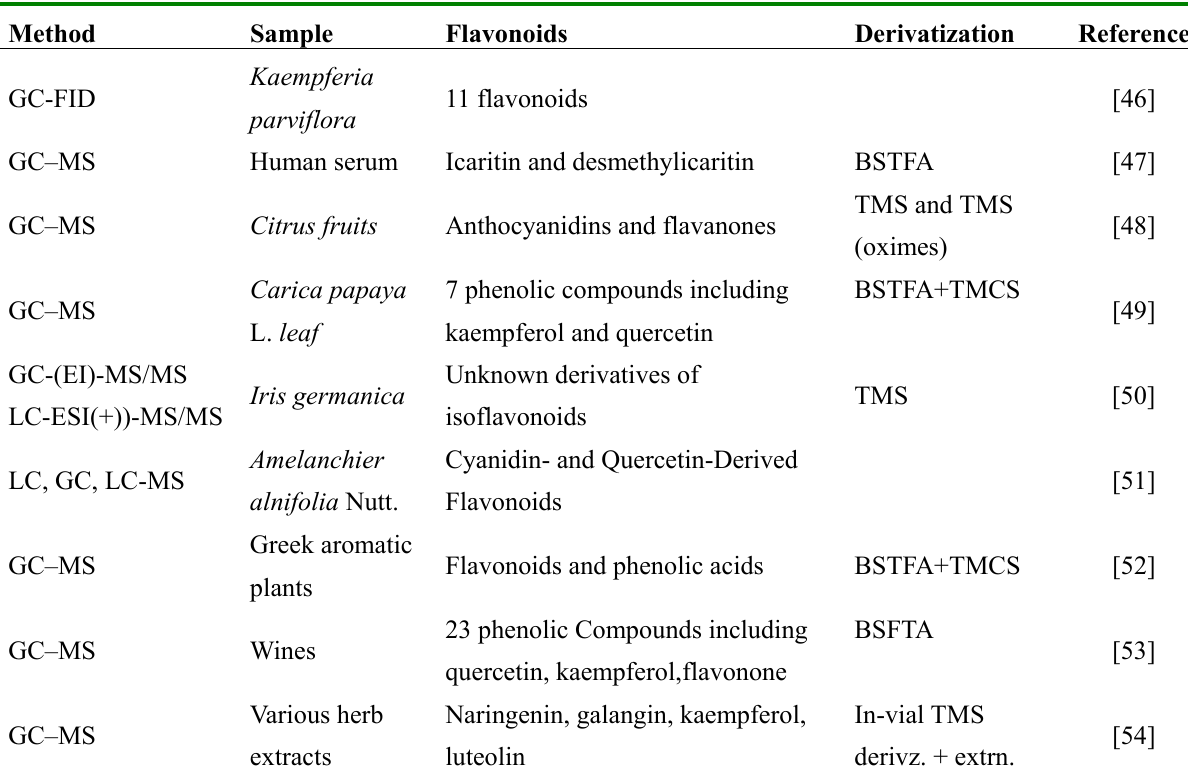
Table 3. Typical applications of GC to flavonoids